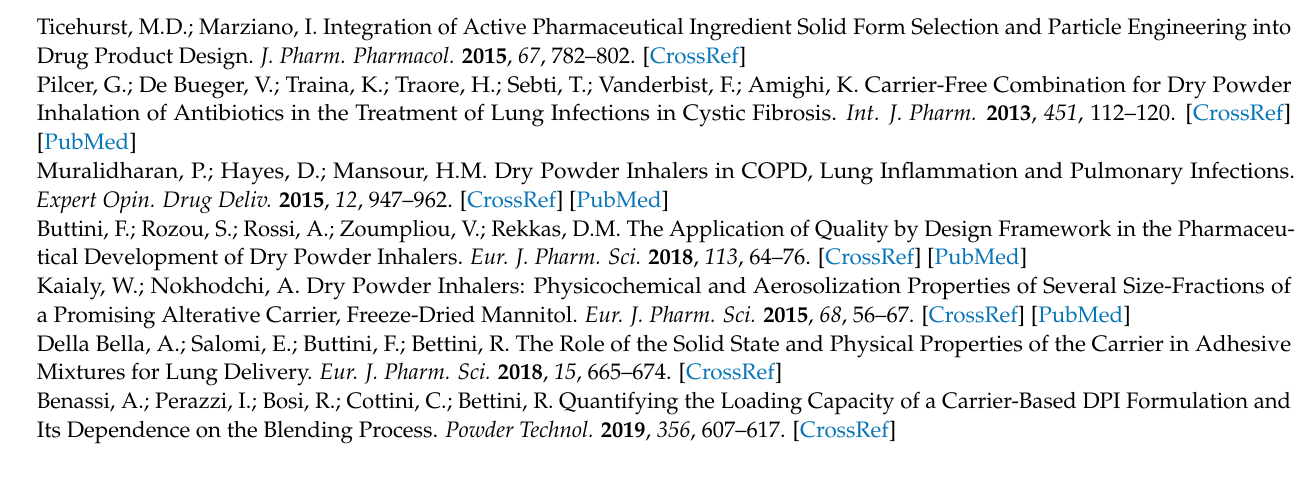
Figure S2: Dynamic vapor sorption profiles of mannitol powders crystallized with different amount of PVP. Figure S3: DSC traces mannitol powders crystallized with different amount of PVP tested after DVS analysis. Figure S4: FPF of SS and BUD vs. resistance of the device used for aerosolizing adhesive binary mixture with lactose